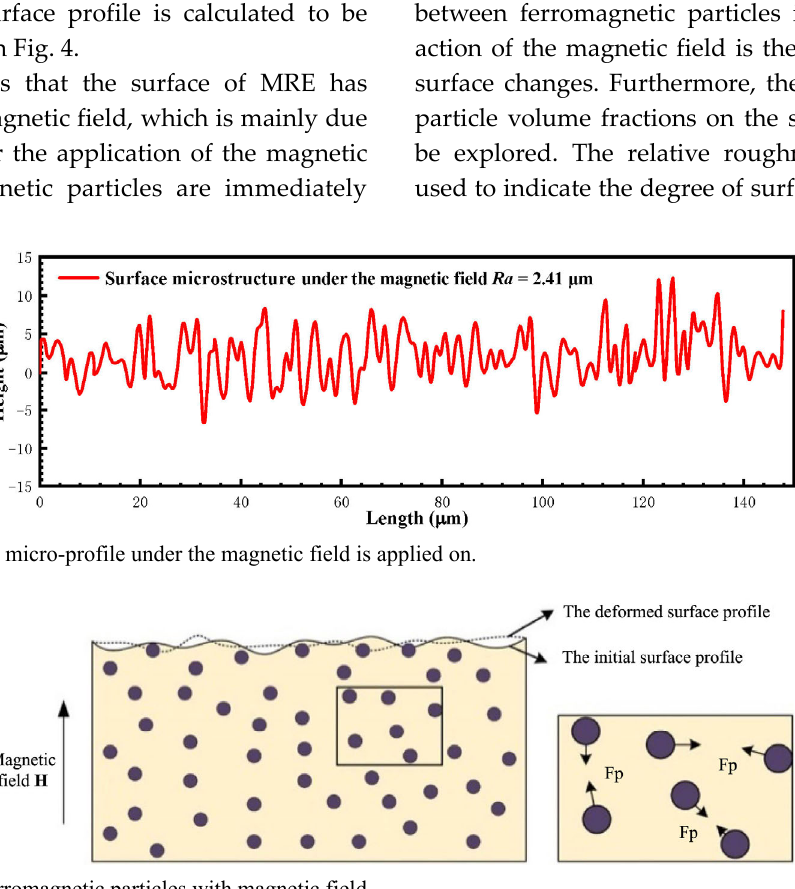
Fig. 5 Interaction of ferromagnetic particles with magnetic